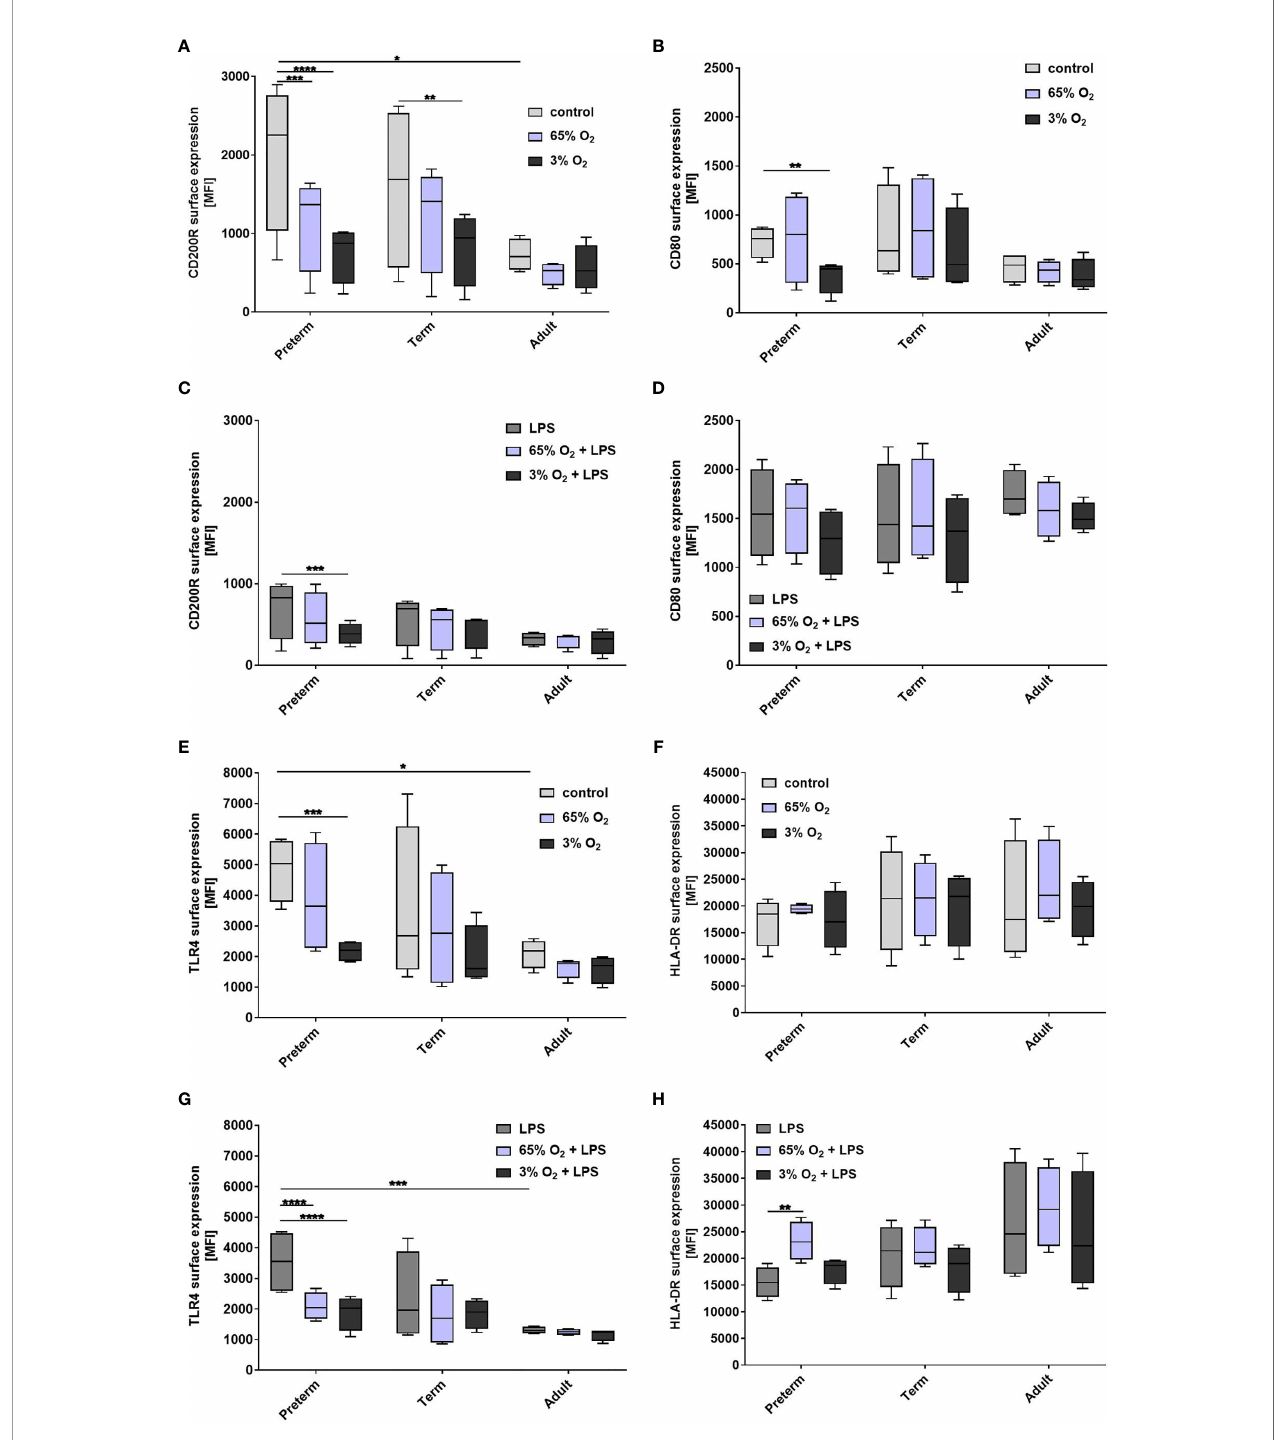
FIGURE 7 | Expression of activation marker on preterm, term, and adult macrophages (M Ф ) primed with various O 2 concentrations followed by LPS. Surface expression of CD200R, CD80, TLR4, and HLA-DR after O 2 exposure only compared to control (21% O 2 ) (A, B, E, F) and after priming with 65% O 2 or 3% O 2 followed by LPS compared to LPS alone (C, D, G, H) incubated for 72 h (48 h 65% O 2 or 3% O 2 followed by 24 h 21% O 2 with or without LPS). Mean fl uorescence intensity [MFI] of surface proteins is shown on macrophages in all three groups assessed by fl ow cytometry. (n=4 independent experiments with cells of four different donors (same donors as Figure 3 ; control and LPS values were re-used from Figure 3 because oxygen and double-hit conditions were included in those experiments), box plots: median ± 25 th to 75 th percentiles and minimum to maximum, ANOVA followed by Holm-Sidak ’ s test, *p < 0.05, **p < 0.01, ***p < 0.001, and ****p <